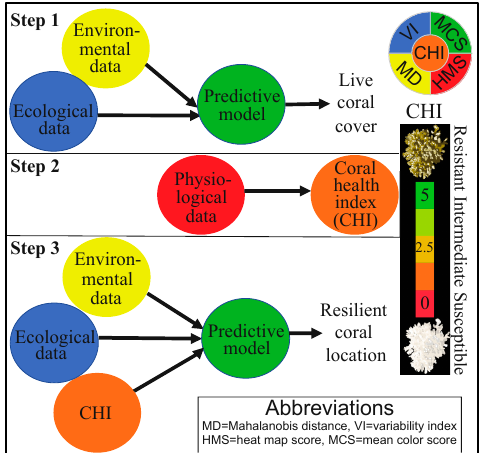
Figure 1. A schematic of the approach. First ( Step 1 ), the environmental and ecological (benthic) data (model X’s) were used to develop a predictive model for coral cover (model Y; discussed in a sister manuscript [21]). The coral physiological data were next used to calculate the “coral health index” (CHI; Step 2 ). Finally, the CHI data were co-analyzed with the environmental and ecological data to develop a model capable of predicting where resilient corals can be found through a machine-learning “desirability analysis” ( Step 3 ). The relative scale of the CHI (0–5) has been shown as an inset to the right.